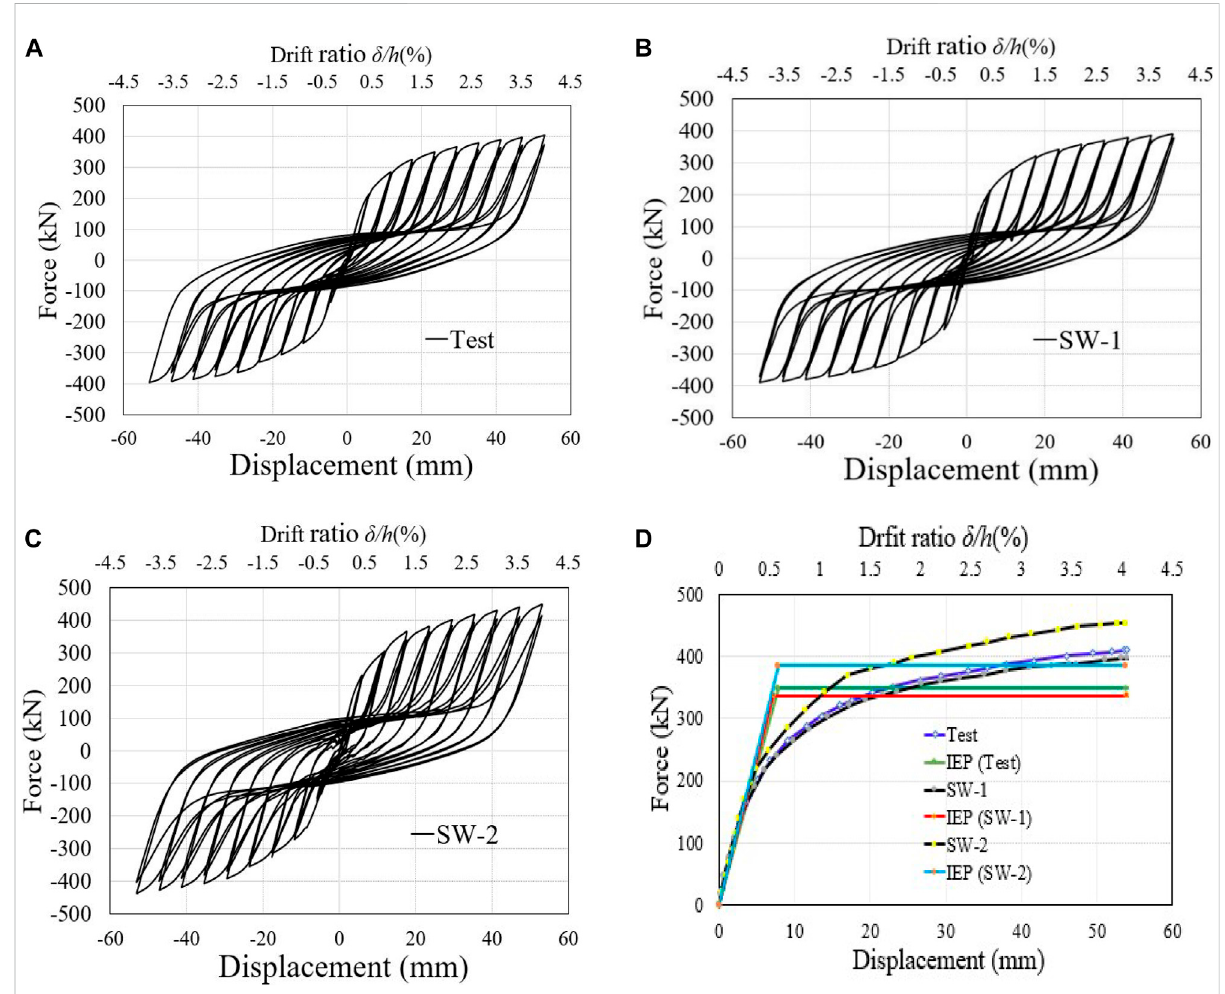
FIGURE 19 Hysteresis, skeleton, and IEP curves of FE model: (A – C) Hysteresis, (D) Pushover, and IEP curves.